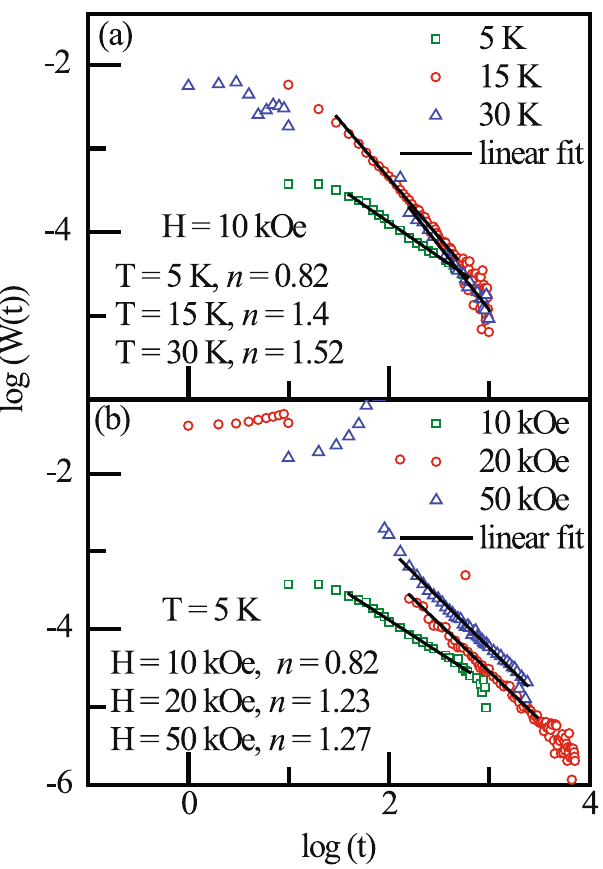
Figure 7. Relaxation rate W(t) for bulk Sm 0.4 Ca 0.6 MnO 3 compound with ( a ) variation of temperature and ( b ) variation of